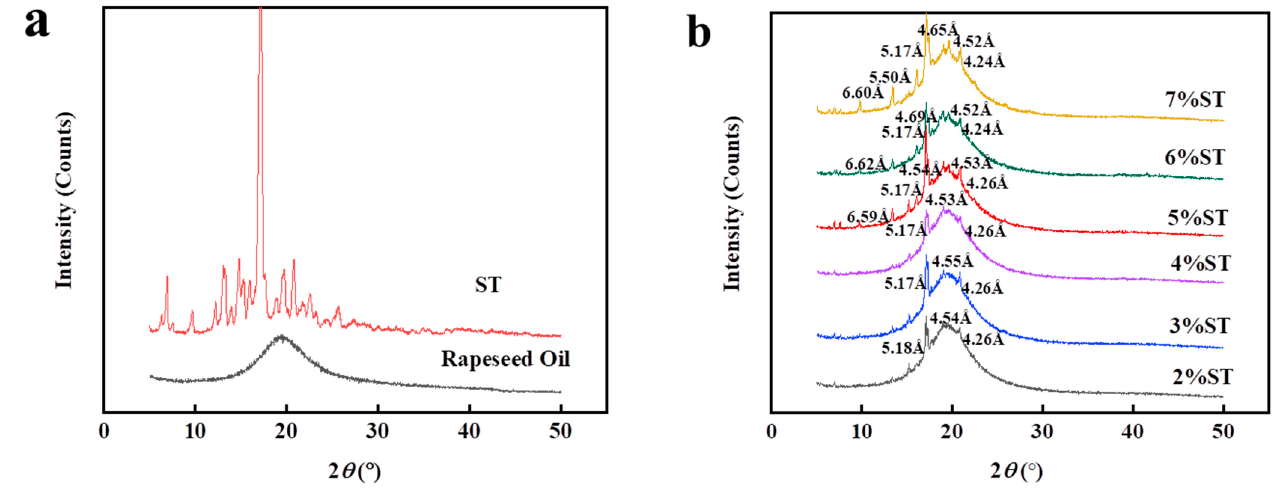
Figure 8. The XRD patterns of rapeseed oil and stigmasterol ( a ); organogels with diverse stigmasterol concentrations ( b ).